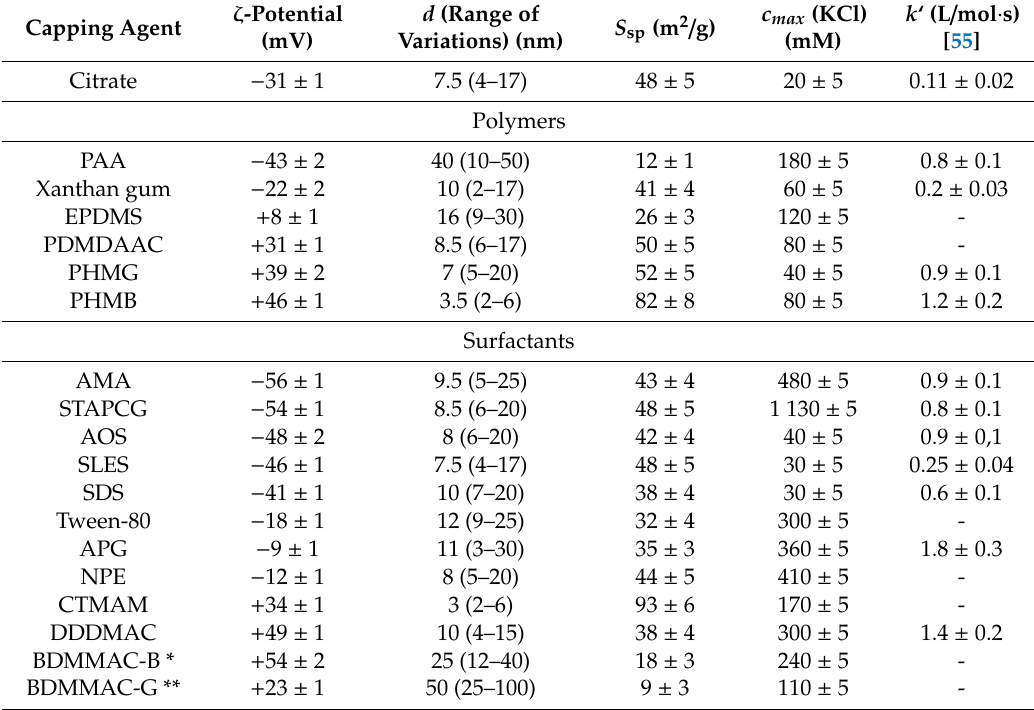
Table 2. Characteristics of the dispersions of silver NPs; d —mean diameter of silver NPs; S sp —specific surface; c max (KCl)—KCl concentration initiating the dispersion coagulation; k ‘—averaged e ff ective rate constant for oxidation of silver NPs by H 2 O 2